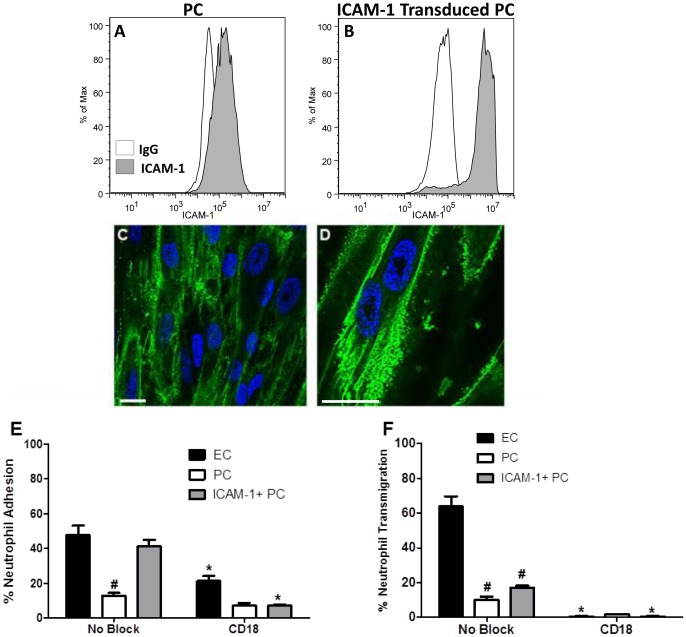
ICAM-1 transduced PC.ICAM-1 expression on (A) non-transduced PC and (B) ICAM-1-transduced PC (ICAM-1+PC) monolayers following 4 hr of activation by IL-1β. ICAM-1 assessed using flow cytometry. ICAM-1 expression on (C,D) ICAM-1 transduced PC following 4 hr of IL-1β activation imaged using confocal microscopy. Bar in (C,D), 20 µm.(E) Neutrophil adhesion on EC, PC or ICAM-1 transduced PC monolayers following 4 hr of IL-1β activation. Freshly isolated neutrophils were pre-incubated with anti-CD18 antibodies and seeded onto the monolayers in Sykes-Moore chambers and allowed to adhere prior to counting. Bars represent average neutrophil adhesion ± SEM. #P<0.05, when compared to no block EC control. *P<0.05, when compared to no block of the same cell control. (F) Neutrophil transmigration across EC, PC or ICAM-1 transduced PC monolayers following 4 hr IL-1β activation. Freshly isolated neutrophils were pre-incubated with anti-CD18 antibodies and seeded onto the Transwell monolayers and allowed to transmigrate for 1 hr. Bars represent average neutrophil transmigration ± SEM. #P<0.05, when compared to no block EC control. *P<0.05, when compared to no block of the same cell layer.